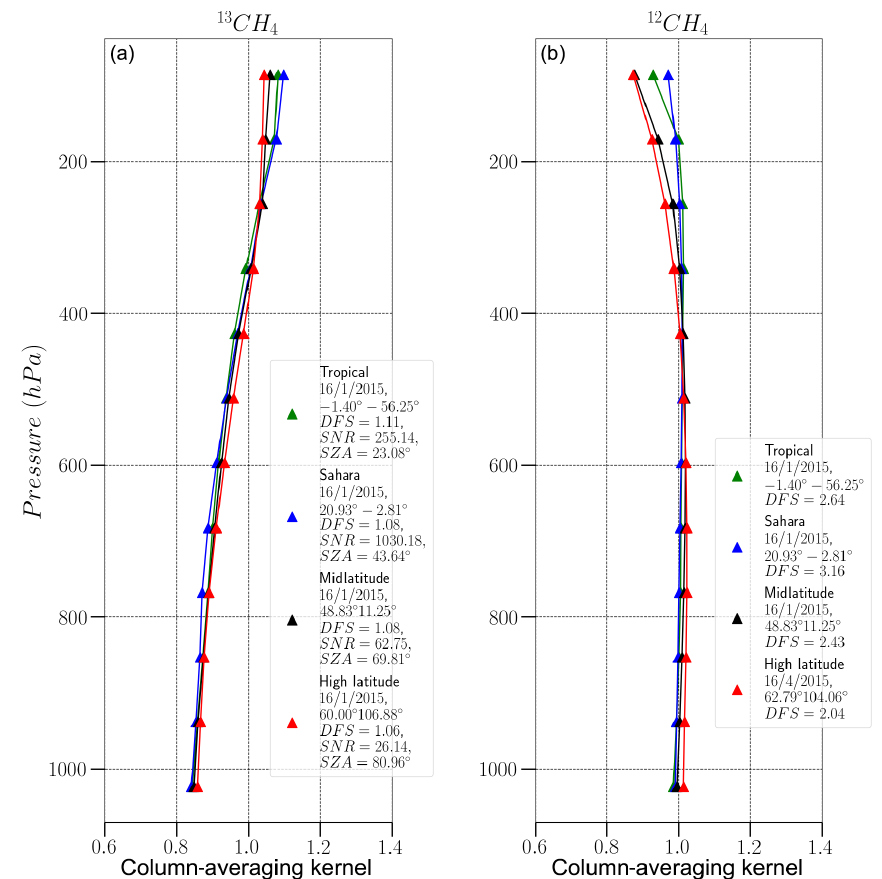
Figure 12. As Figs. 2 and 8 but focused on a combination of the SWIR channels from Sentinel-5.